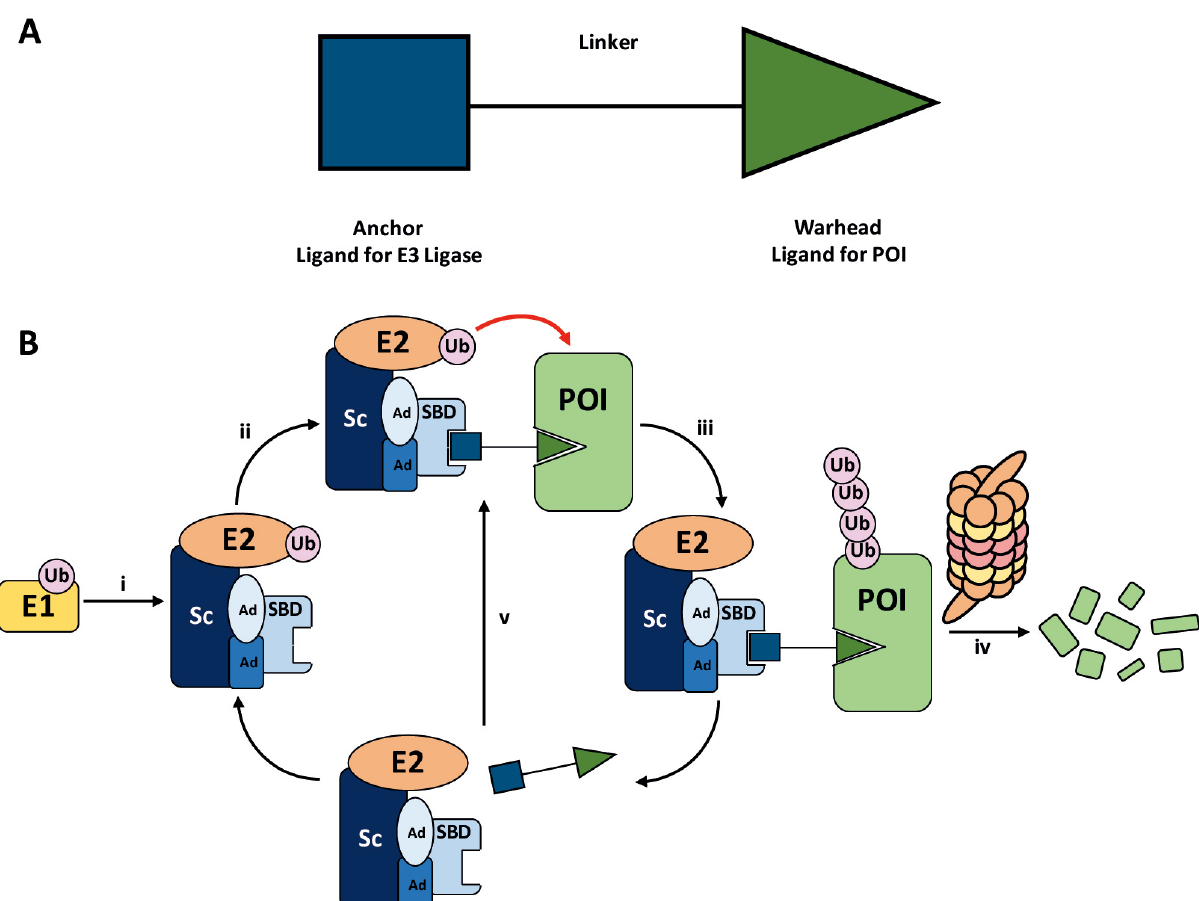
warhead (green) via a variable linker; B. mechanism of PROTAC-mediated target degradation via RING-type E3 ligases. (i) Ub transfer from E1 to E2 by trans-thioesterification is followed by complex formation with an E3 ligase; (ii) the PROTAC binds to both the E3 ligase and POI to form a TC, where the E3 ligase is shown as an assembly of scaffolding proteins (Sc), adapter proteins (Ad), and a SBD. This brings the E2 ligase into proximity to the POI; (iii) this leads to the transfer of multiple Ub units to surface exposed lysine residues; (iv) the resulting polyubiquitin chain is recognised by the proteasome, leading to the proteolytic degradation of the POI; and (v) the PROTAC is released and can catalyse the transfer of Ub to additional